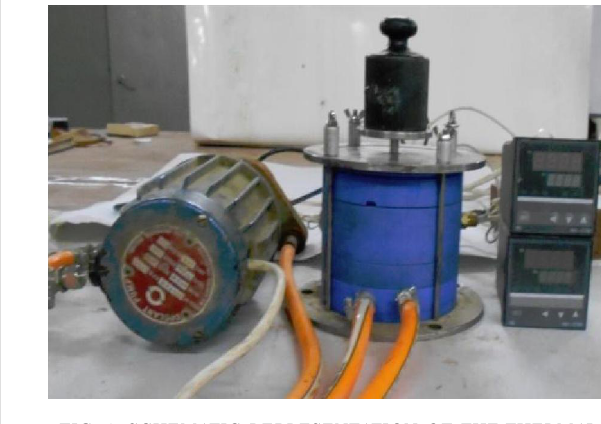
FIG. 4. SCHEMATIC REPRESENTATION OF THE THERMAL CONDUCTIVITY DEVICE IN